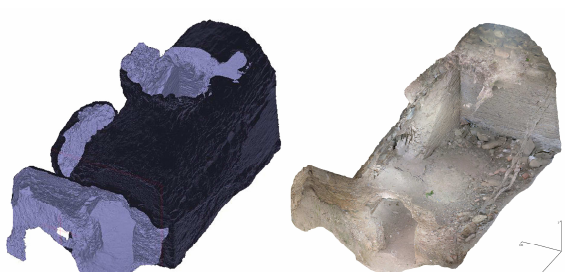
Figure 5. Orthophotographs of the upper cistern of the fortress of La Rijana.